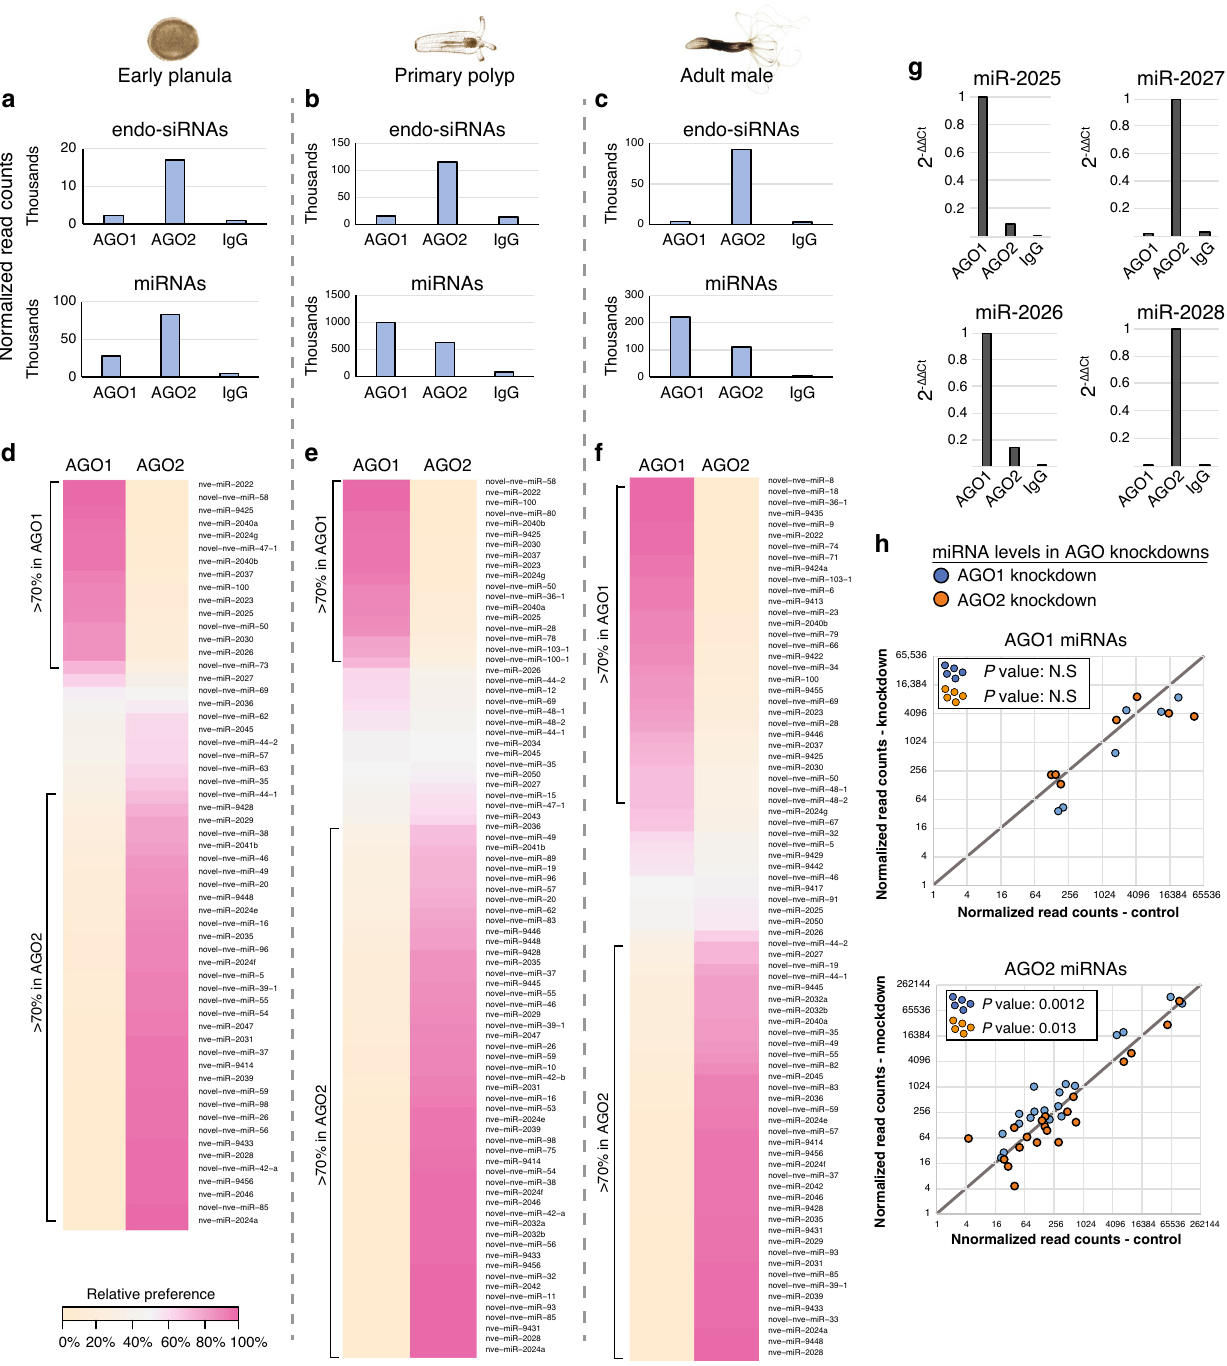
Fig. 4 miRNA and endo-siRNA distribution between the two Nematostella AGOs. a – c Normalized read-counts of miRNAs (lower panels) and endo- siRNAs (upper panels) in sRNA libraries generated from Nematostella AGO IPs. Each bar represents the average of two distinct biological replicates normalized as described in the “ Methods ” section. d – f Heat map representing the relative preference of individual miRNA guides to NveAGO1 or NveAGO2, validated by qPCR for 9-day-old primary polyps ( g ) for two NveAGO1 and two NveAGO2 miRNAs. h Levels of miRNAs with >90% preference for NveAGO1 (upper panel) and for NveAGO2 (lower panel) in AGO1 knockdowns (compared to control, blue dots) and AGO2 knockdowns (orange dots). A two-tailed binomial signi fi cance test was used to determine whether miRNA levels change following AGO knockdown (compared to their levels in controls, Supplementary data aligned the miRNAs of each NveAGO and calculated for each Data 4). 65% of NveAGO1 miRNAs (26/40) tend to have at least position of the guide-strand the frequency of mismatches between one central mismatch, compared to only 18% of NveAGO2 guide and star. For NveAGO1 miRNAs, there is a noticeable miRNAs (11/60). This is comparable to Arabidopsis where 65.7% tendency to be enriched with mismatches in positions 10 – 12 of AthAGO1 enriched miRNAs (23/35) contain central mis- compared to NveAGO2 miRNAs (Fig. 5b, Supplementary matches in their duplexes compared to 20% of AthAGO2